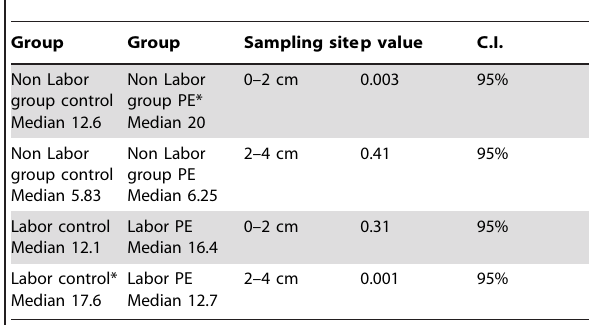
Table 2. Shows the median optical density for each group of patients and p value for each comparison from all patients combined for Western blot analysis of HSP 70 expression in non labor control versus non-labor PE at 0–2 cm site, non labor control versus non-labor PE at 2–4 cm site, labor control verus labor PE at 0–2 cm site and labor control versus labor PE at 2–4 cm site.